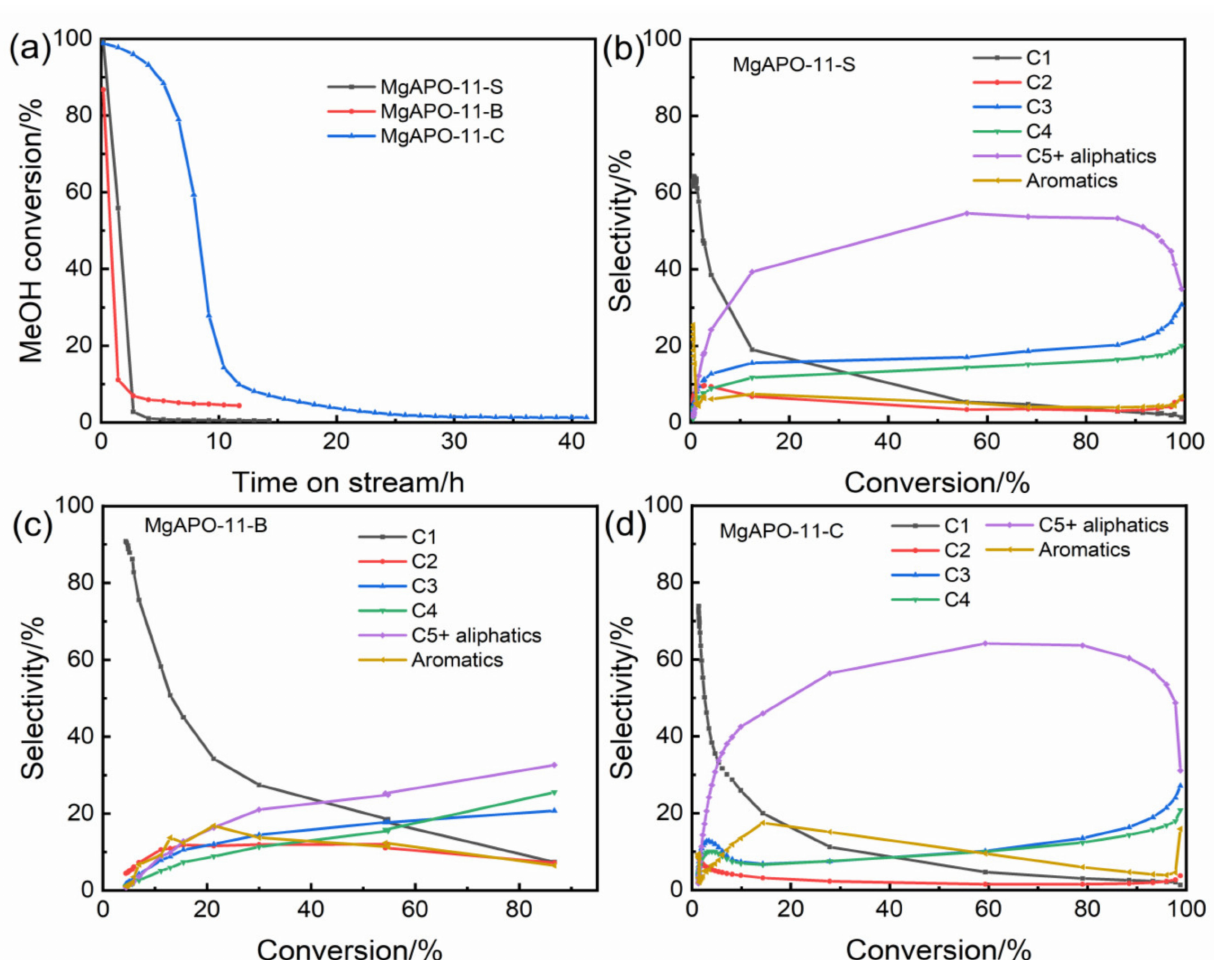
Figure 4. MTH performance of three MgAPO-11 catalysts at 450 ◦ C and WHSV = 0.5 h − 1 . The data were obtained during catalyst deactivation: ( a ) MeOH conversion versus time on stream for all three MgAPO-11 samples, ( b ) conversion versus selectivity performance of MgAPO-11-S, ( c ) conversion versus selectivity performance of MgAPO-11-B, ( d ) conversion versus selectivity performance of